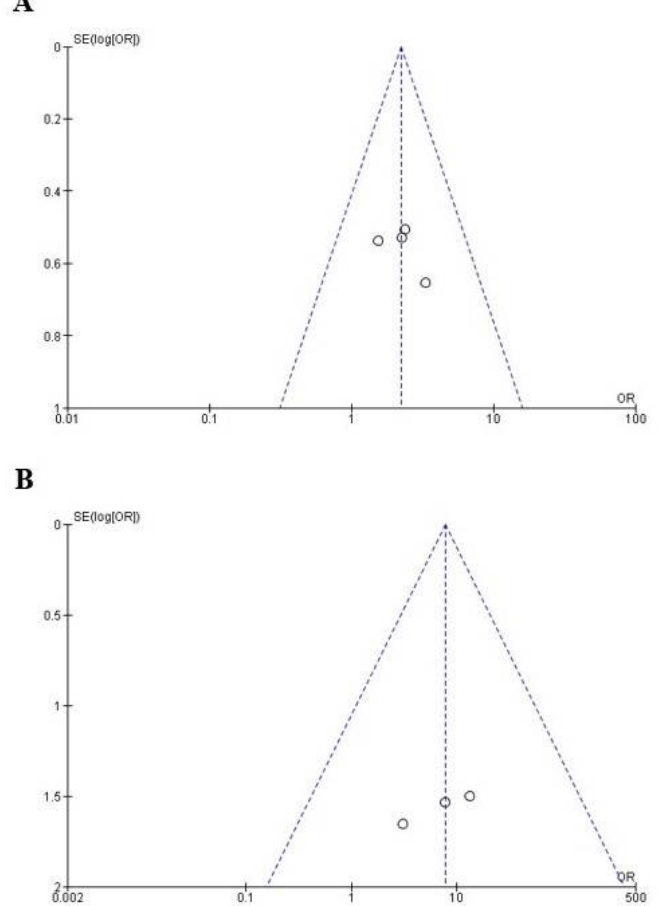
Figure 5. Evaluation of publication bias of the anesthetic success ( A ) and adverse effects ( B ) varia- bles.